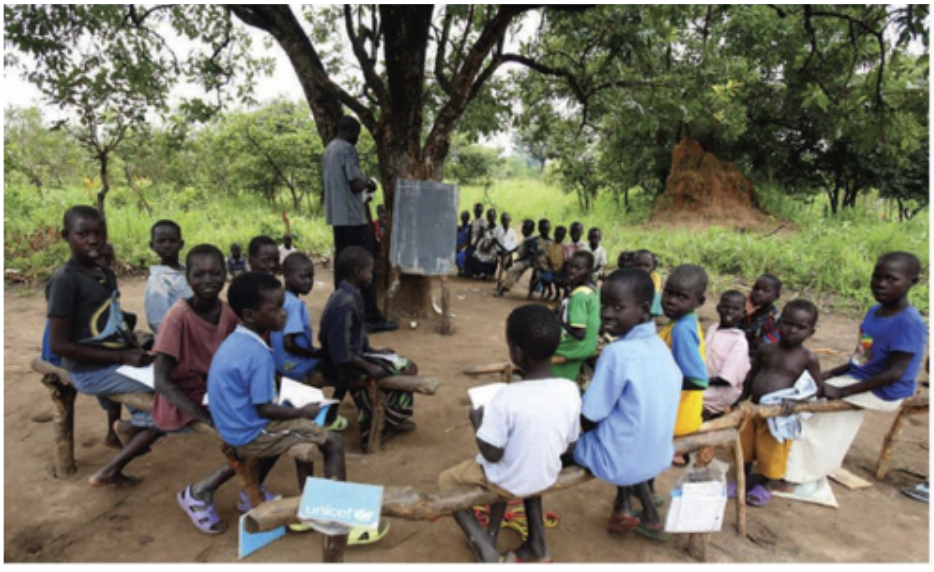
Figure 3. Pupils studying under a